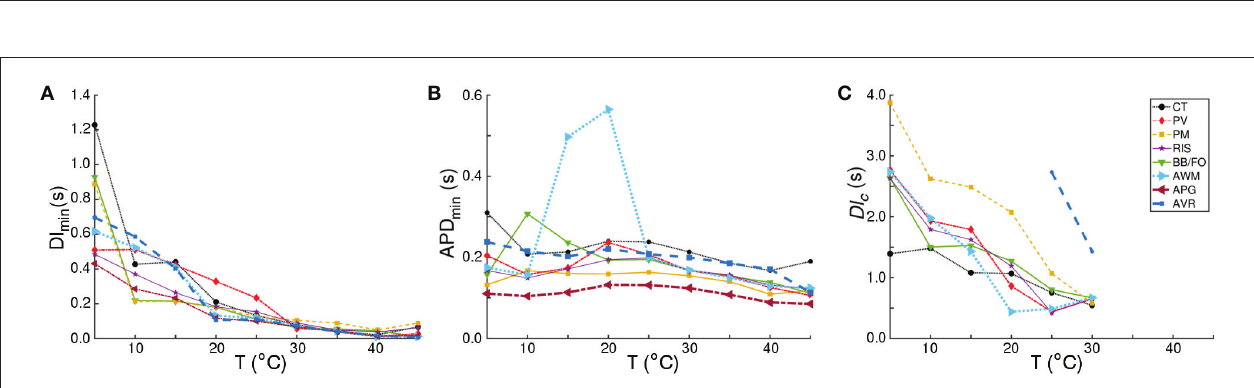
FIGURE 5 | Temperature-dependence of APD 90 restitution curves recorded from (15.36 × 3 mm) tissue strip containing cells from (A) CT, (B) BBFO, (C) PM, (D) PV, (E) RIS, (F) AWM, (G) APG, and (H) AVR, respectively. Restitution was measured using the dynamic S1-S2 protocol, whereby, each tissue strip was first allowed to reach a steady state at a given temperature (5 ◦ < T < 45 ◦ C ). Then a series of 20 S1 pulses were applied at the left end of the strip, at a pacing frequency of 1 Hz. Finally, a 21 st stimulus (S2) was applied in a similar manner, but after a variable diastolic interval (DI). Our results indicate the occurrence of a phenomenon similar to a first order state transition, at very low temperatures in most atrial regions. At high ( T > 40 ◦ C ), the APD restitution curves exhibit a negative slope.